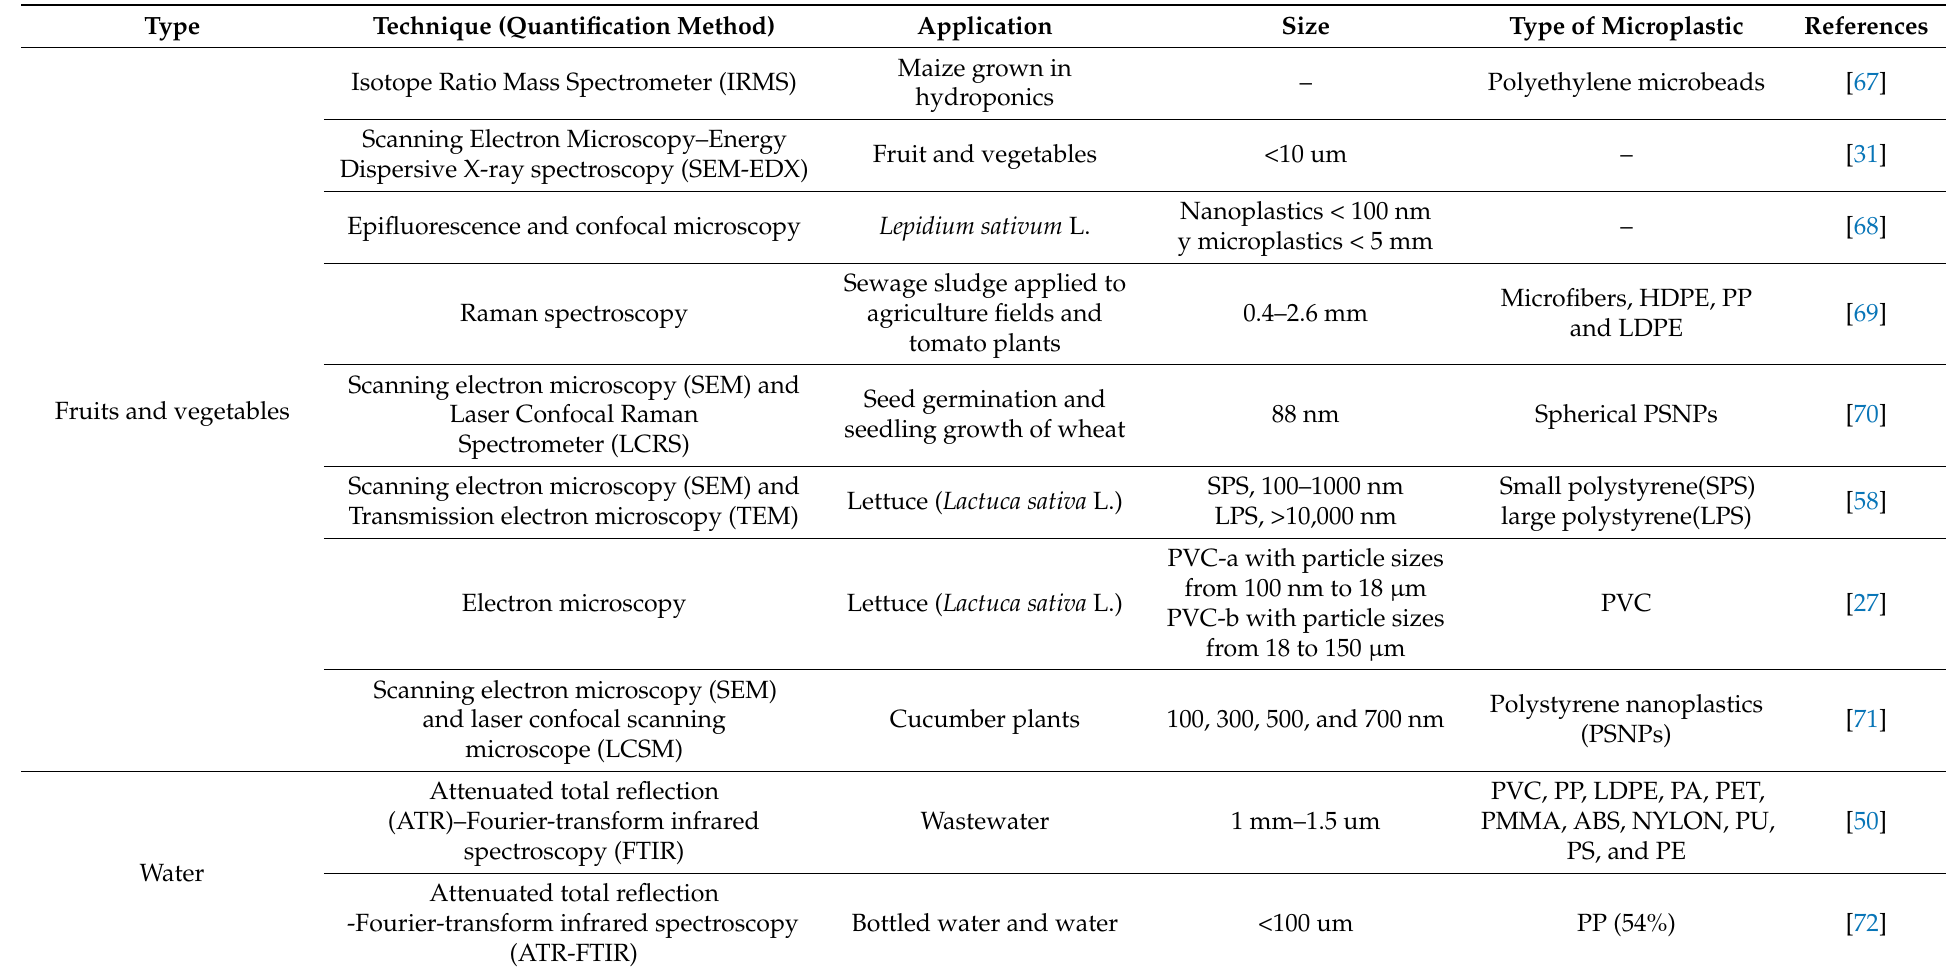
Table 1. Identification and quantification techniques of microplastics and nanoplastics in different